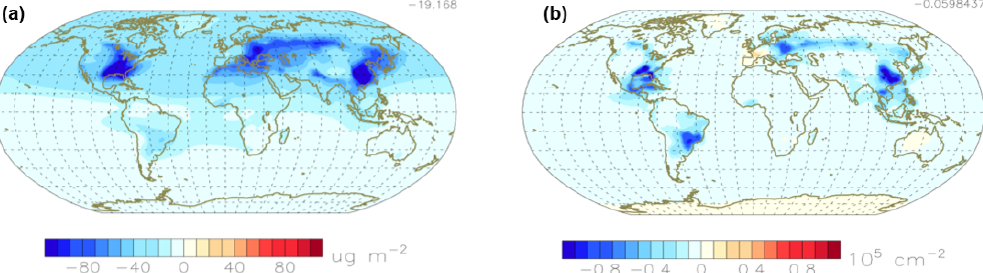
Figure 13. Simulated (a) organic aerosol column burden change and (b) cloud droplet concentration changes between 1850 and 2000; attributed to anthropogenic land-use change